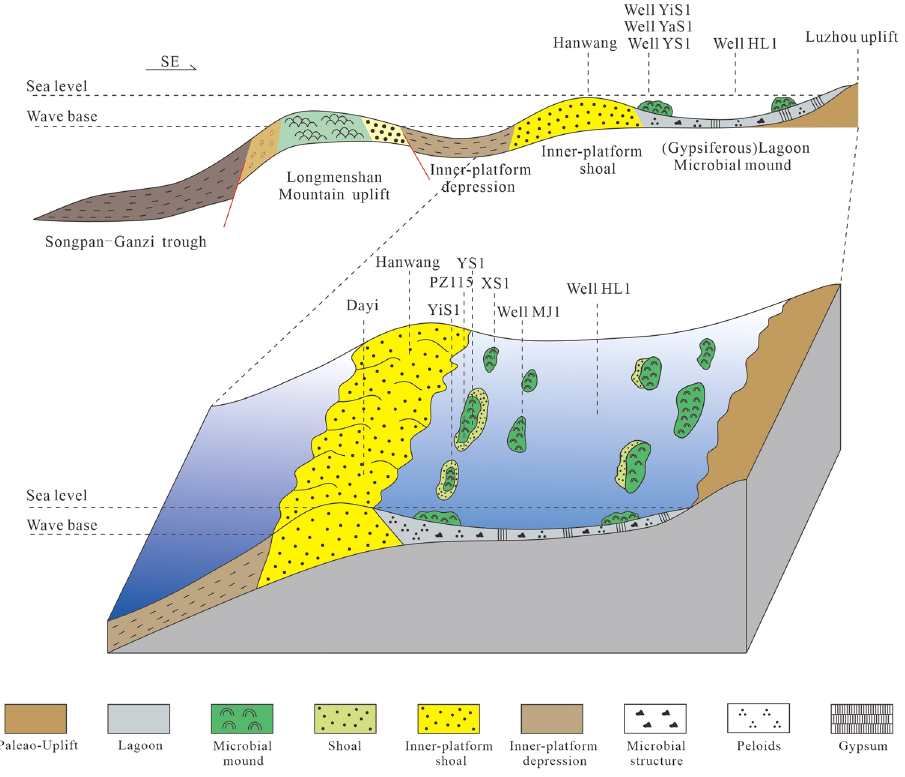
Figure 7. Sedimentary model of the Leikoupo Formation in Western Sichuan